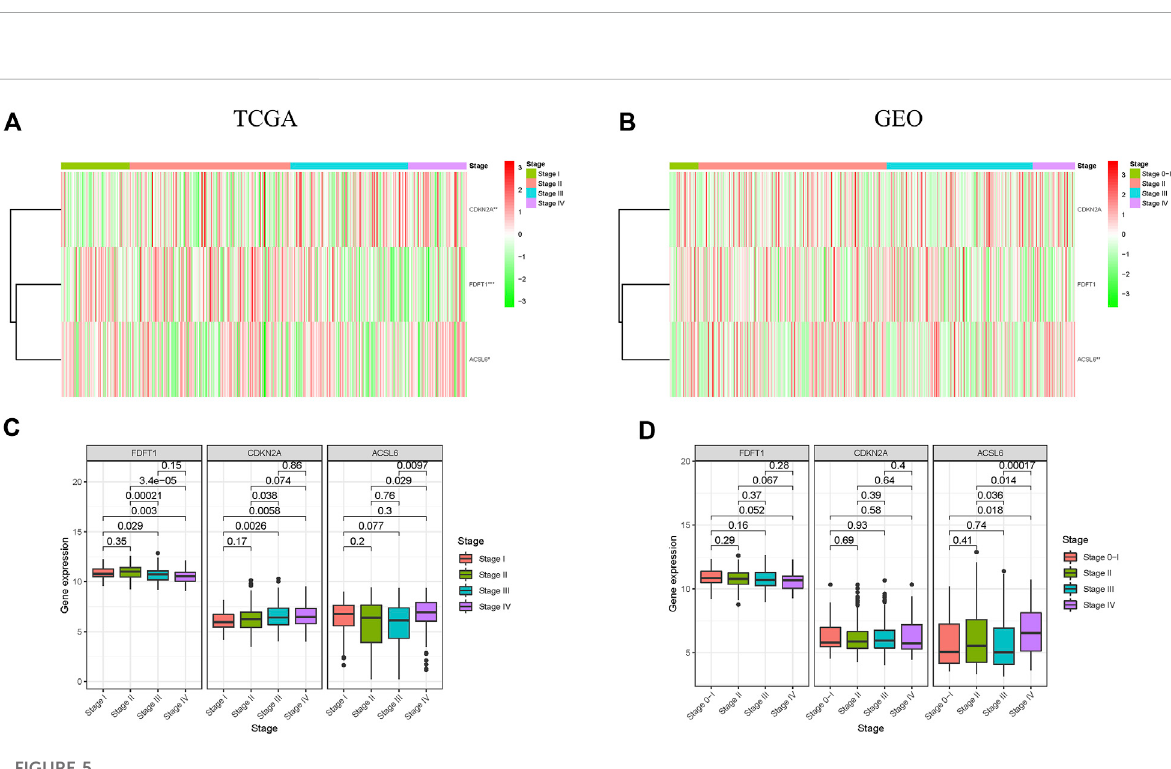
FIGURE 4 Constructing and verifying a nomogram. (A,C) The prognostic nomogram developed according to the risk scores of ferroptosis-associated genesandclinicopathologicalfeaturespredicted the1-,3-,and5-yearOS ofCRC patientsintheTCGAandGEOcohorts. (B,D) Calibrationcurvesof nomogram on consistency between predicted and observed 1-, 3-, and 5-year survival in the TCGA and GEO cohorts.